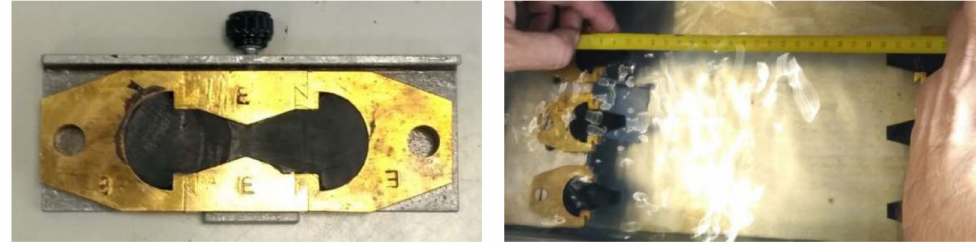
Figure 1. Elastic recovery test of polymer-modified binders: molds and measuring procedure.